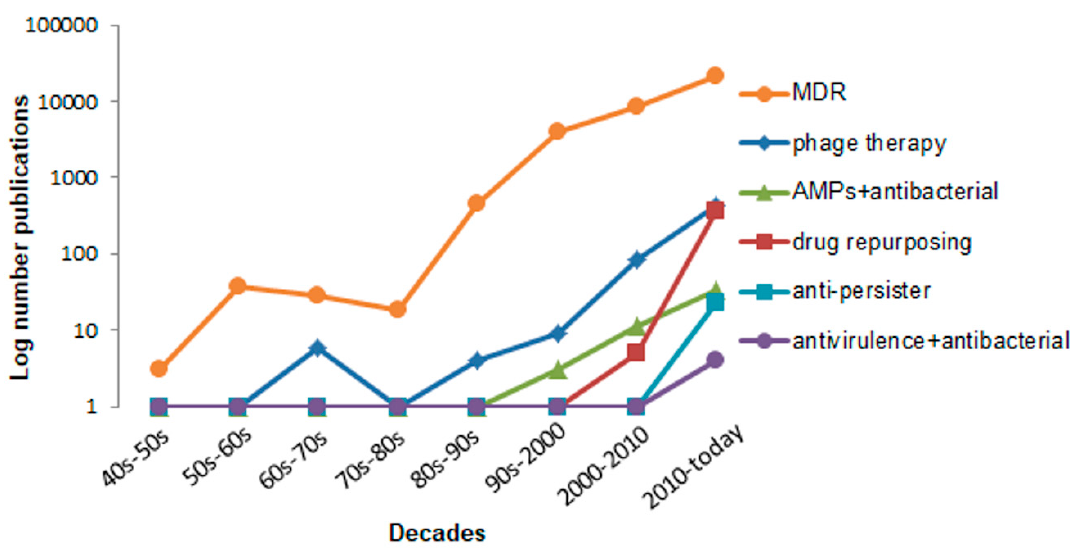
Figure 2. Number of annual publications available on PubMed search engine for the keywords “MDR OR multidrug resistance”, “phage therapy”, “antimicrobial peptides AND antibacterial”, “drug repurposing”, “anti-persister OR anti-persistence OR resuscitating drugs”, “anti-virulence AND antibacterial”. The number of publications is expressed on a logarithmic scale.